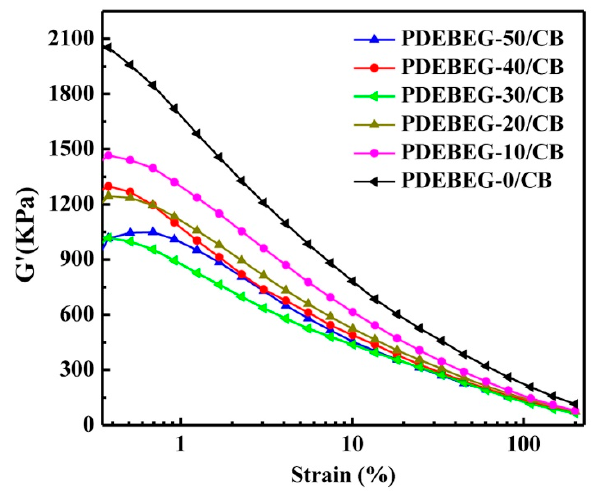
Figure 7. Strain amplitude dependence of G’ of the PDEBEG/CB compounds.